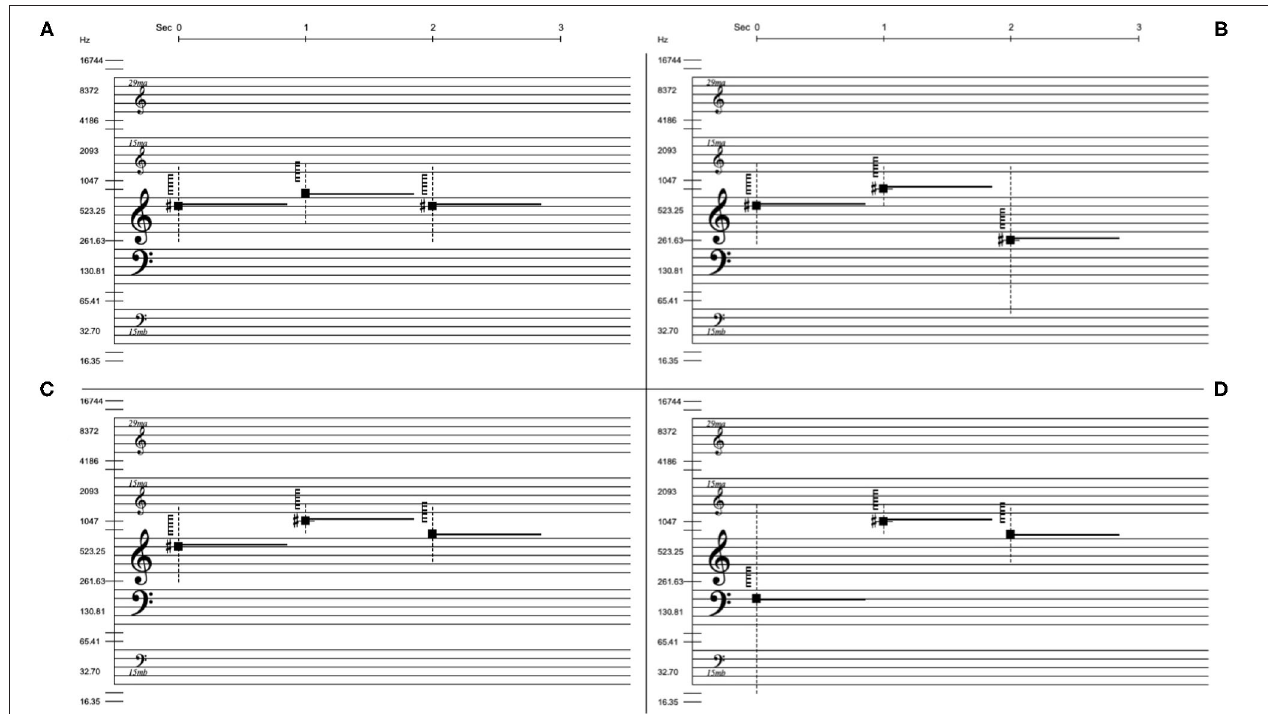
FIGURE 5 | The four notation choices for question #5 of the multiple choice listening text. For this question, lower limit of spectral width is in focus, indicated by the lower end of the dashed vertical line. (C) is the correct answer and it shares its overall frequency contour with (D) . (A) and (B) are incorrect but are still fairly similar to (C) and (D) .